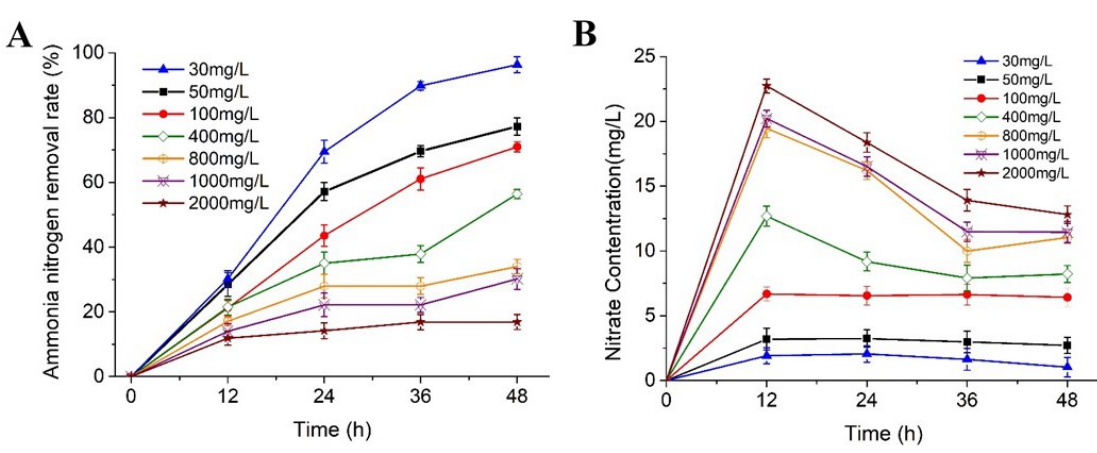
Figure 5. ( A ) Nitrogen removal rates and ( B ) accumulation of NO 3 − -N in cultures containing di ff erent concentrations of ammonia.